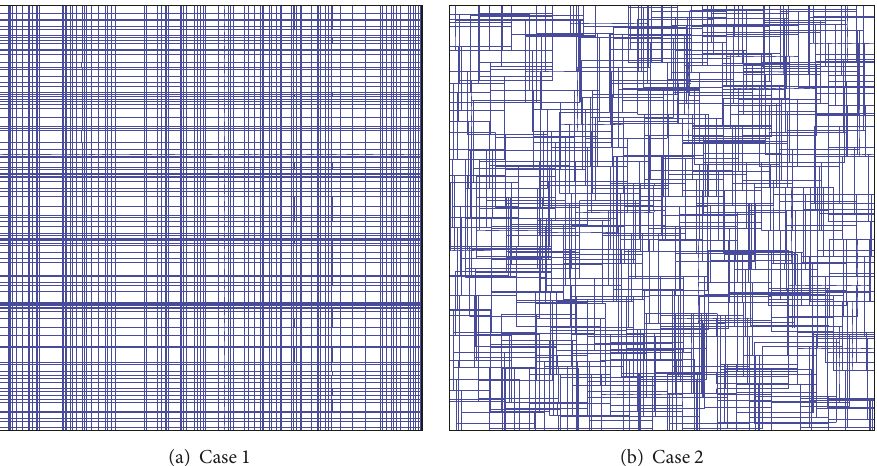
Figure 7: Numerical generations of two fracture systems: (a) fracture sets with mean trace length of 2 m and spacing of 0.005 m and (b) fracture sets with mean trace length of 0.2 m and spacing of 0.01m. Table 1: Parameters of fractures and probability